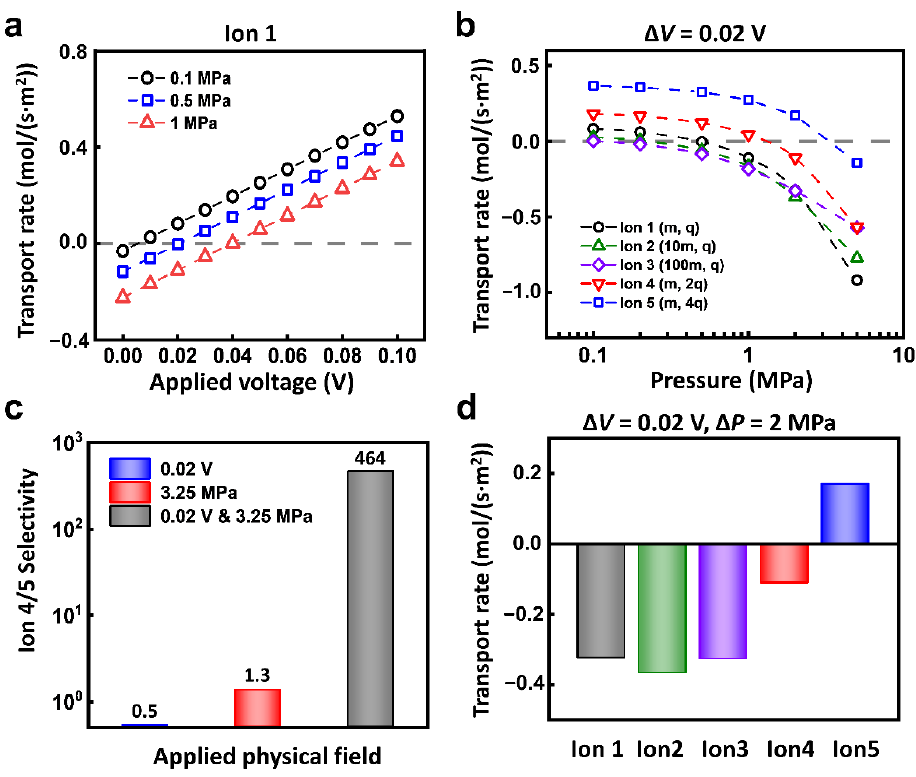
Figure 4. The multi-physical fields can evidently enhance ion selectivity. ( a ) Under fixed hydraulic pressure conditions, the ionic transport responds to the electric field. ( b ) Under the voltage condition of 0.02 V, the ionic transport of different ions can be regulated by applied hydraulic pressure. ( c ) The selectivity ratio of Ion 4 and Ion 5 under 0.02 V and 3.25 MPa is much higher than that under a single physical field. ( d ) Through the combination of appropriate electric potential and hydraulic pressure, the efficient separation of target ions (for instance, Ion 5) can be achieved.